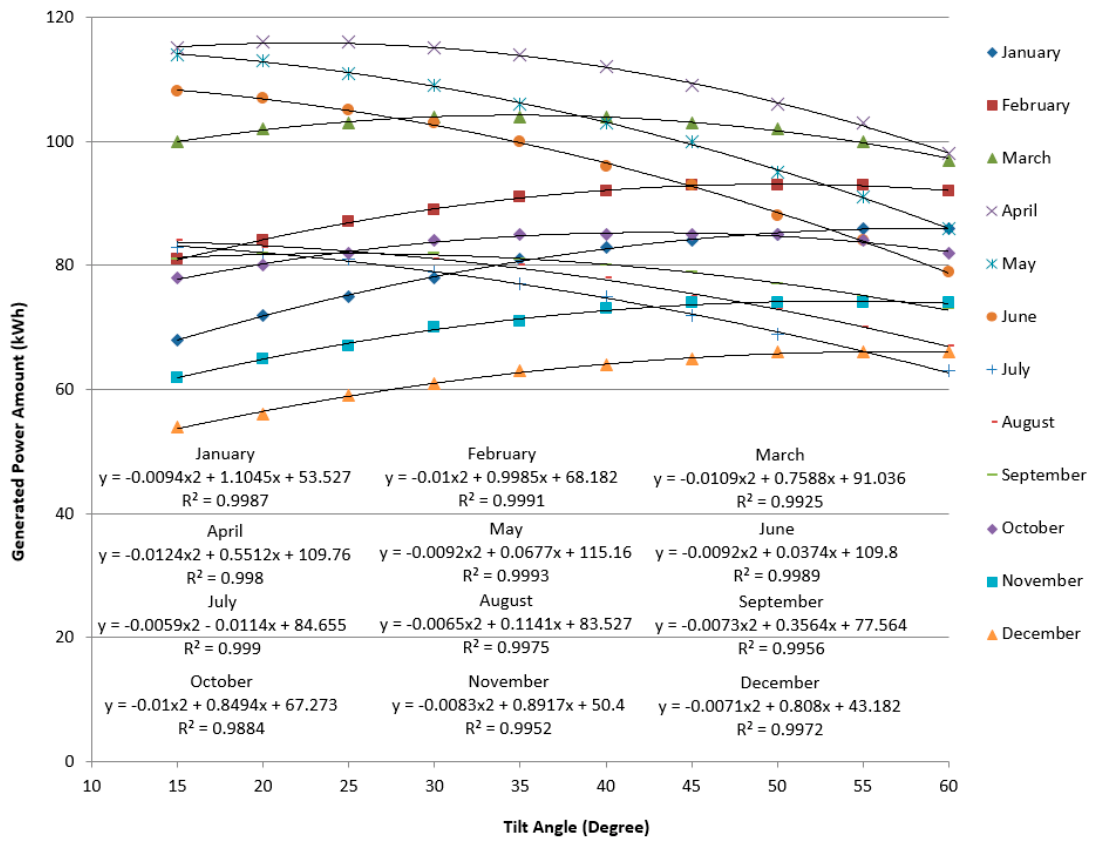
Figure 3. Monthly photovoltaics (PV) generation amounts with different tilt angles.